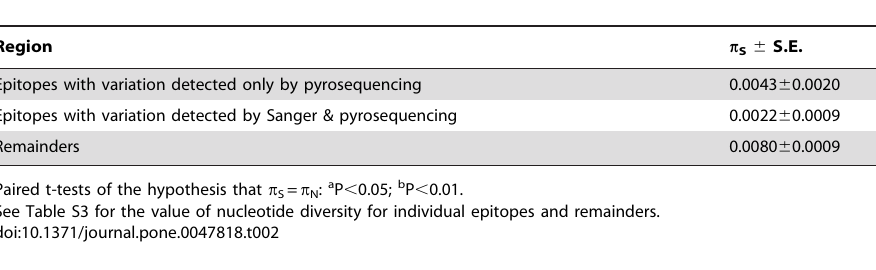
Table 2. Synonymous ( p S ) and nonsynonymous ( p N ) nucleotide diversity in variant epitopes from CY0163, CY0164, and CY0166.